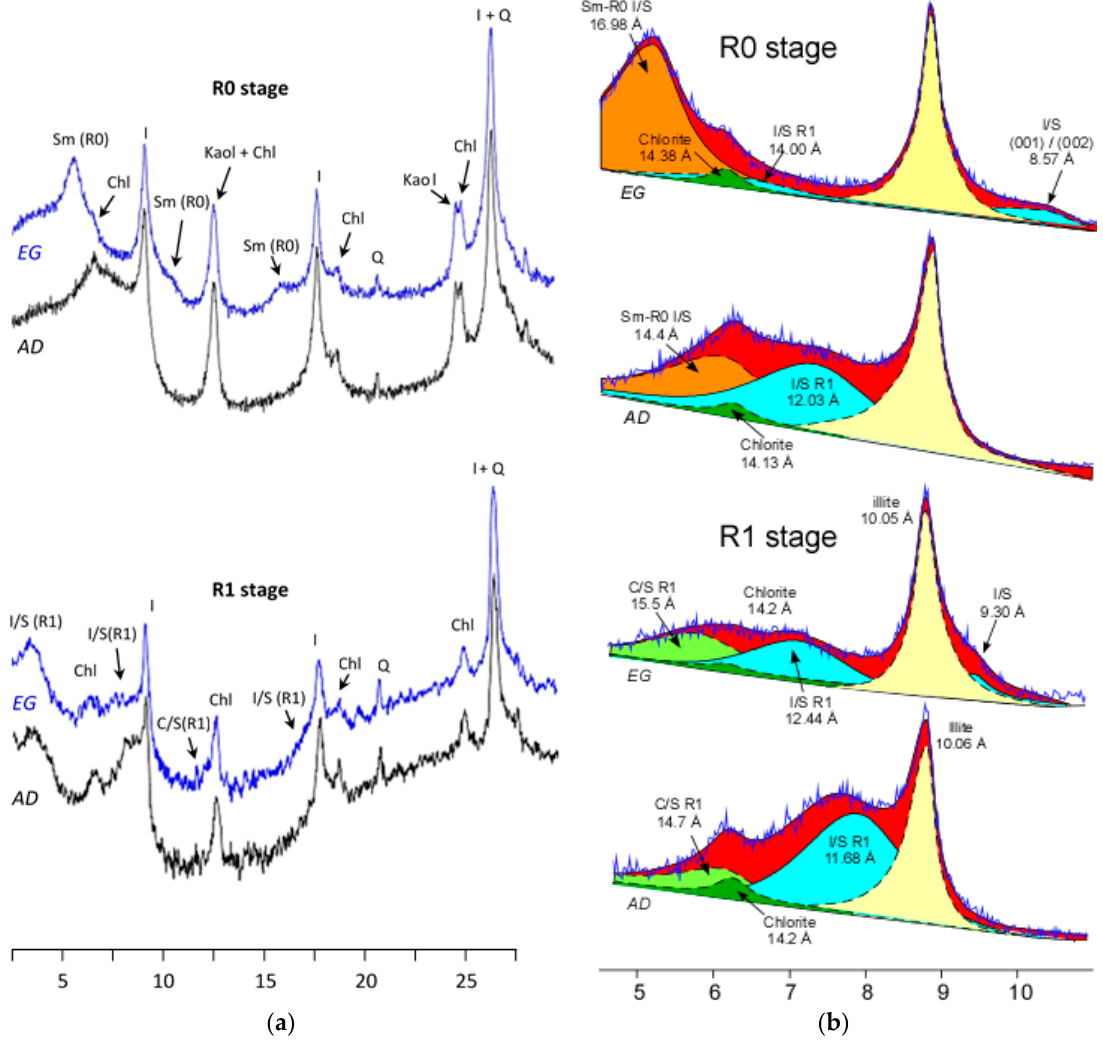
Figure 2. XRD profiles corresponding to <2 µm oriented fraction representative of stages, R0 and R1, ( a ) air dried an glycolated; ( b ) decomposed profiles.